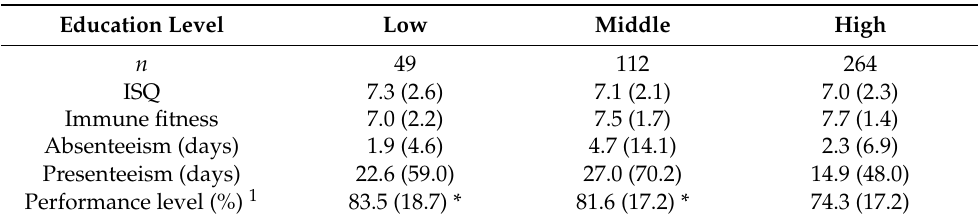
Table 5. Absenteeism, presenteeism, and work performance on days with reduced immune fitness according to education career